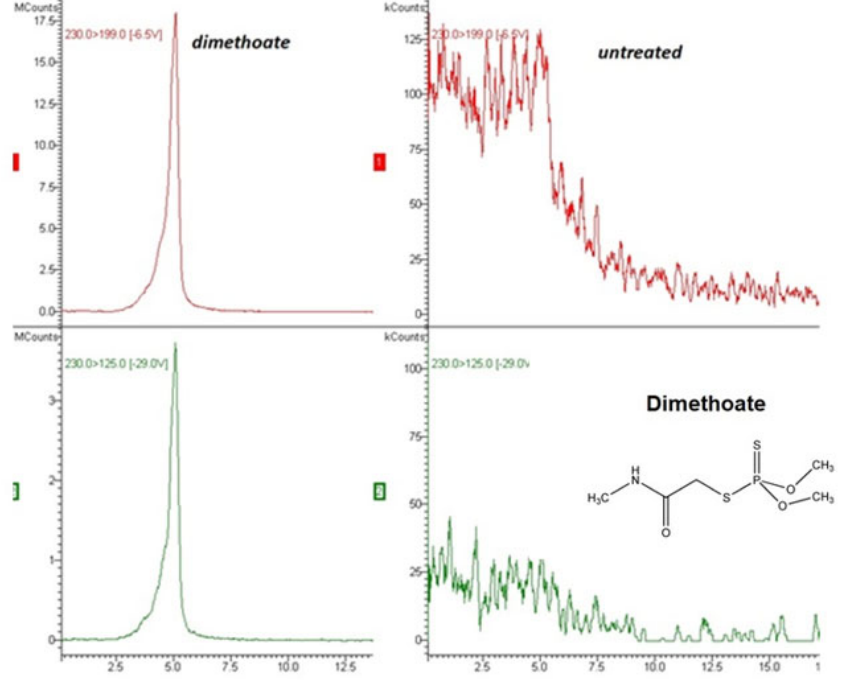
Figure 1. Determination of dimethoate residues in the surface of olive leaves using LC-MS/MS system. For phosmet the retention time was 7.65 min; the transition 317.9-> 133.1 m/z (48